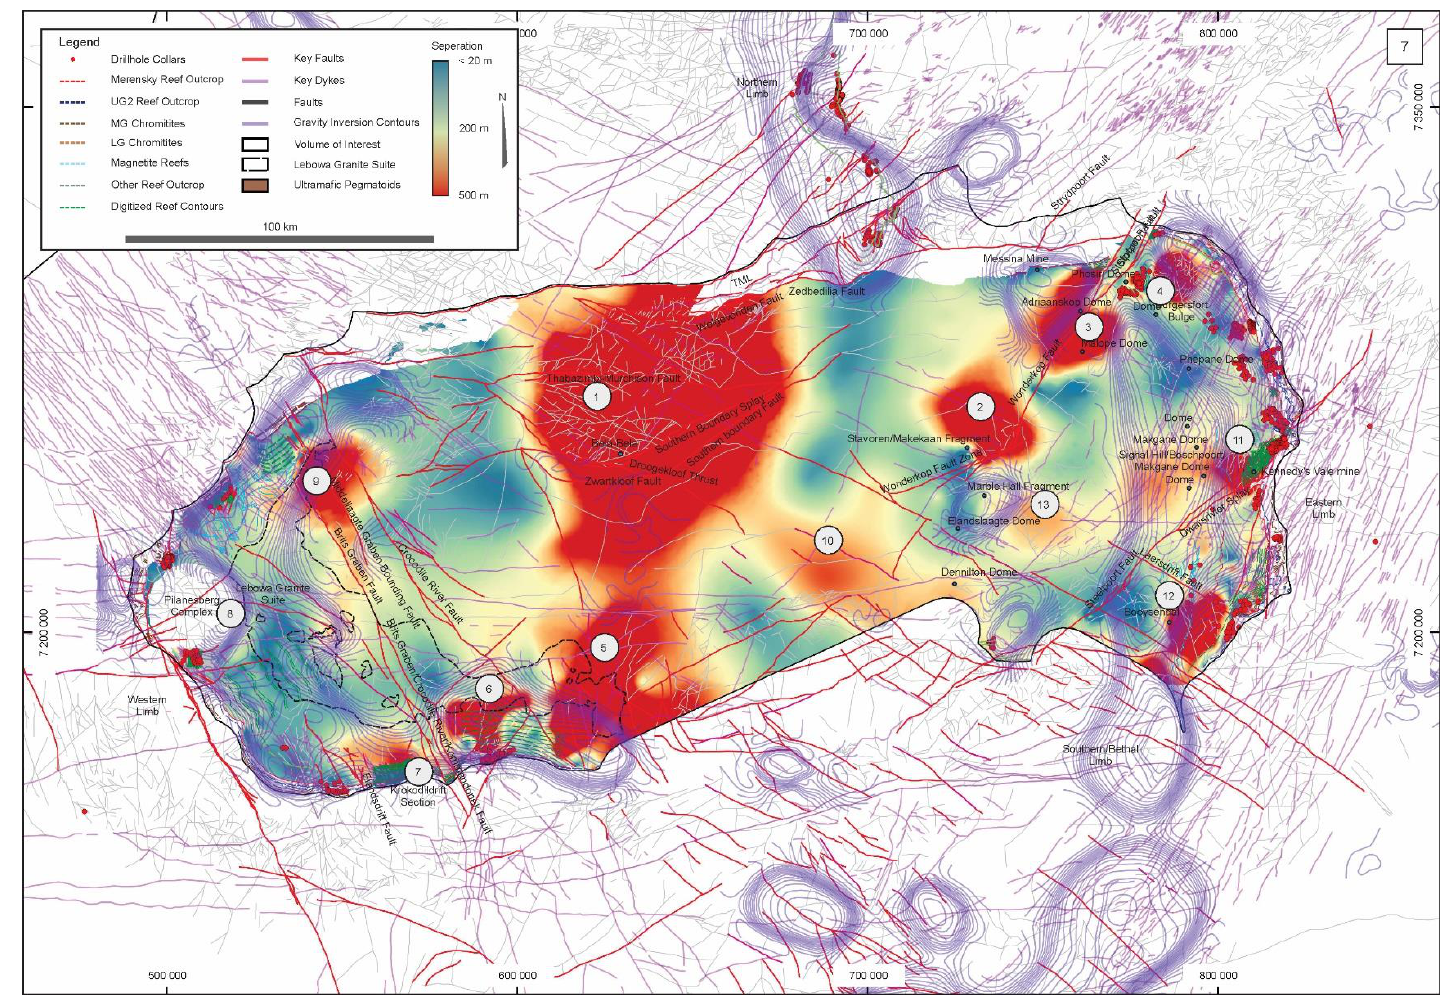
Figure 7. Calculated inter-reef separation or middling (m) between the UG2 and Merensky reefs. Numbered points of interest are discussed in the text.